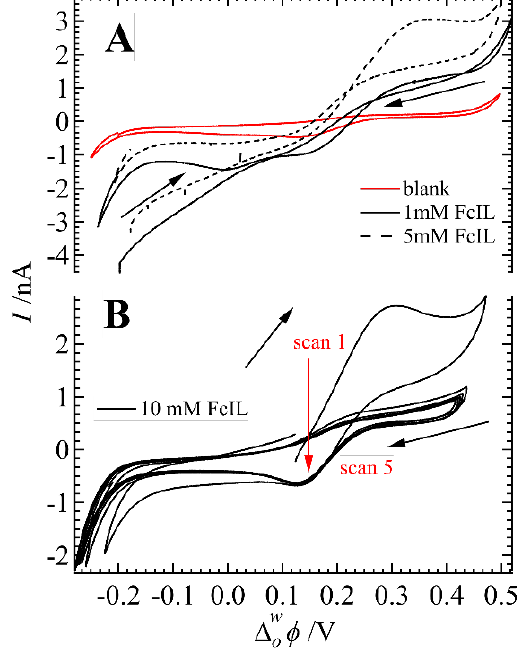
Figure 4. i – V measurements using Cell 2a at a 25 µm diameter interface with [FcIL], or y , equal to 0, 1, and 5 mM ( A ) as well as [FcIL] = 10 mM ( B ) with multiple scans as indicated inset, performed with a scan rate of 0.020 V s –1 . Black arrows show scan direction.